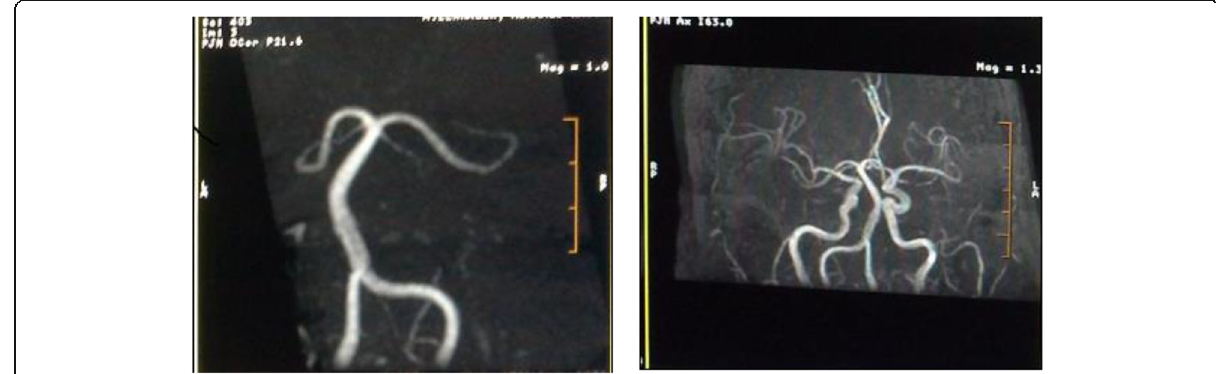
Fig. 2 MRA brain of patient presented with left insular, periventricular infarction, and diffuse atherosclerosis of intracranial vessels. NIHSS score was 5 on admission, 0 after 3 months, ApoA1 level was 5 μ